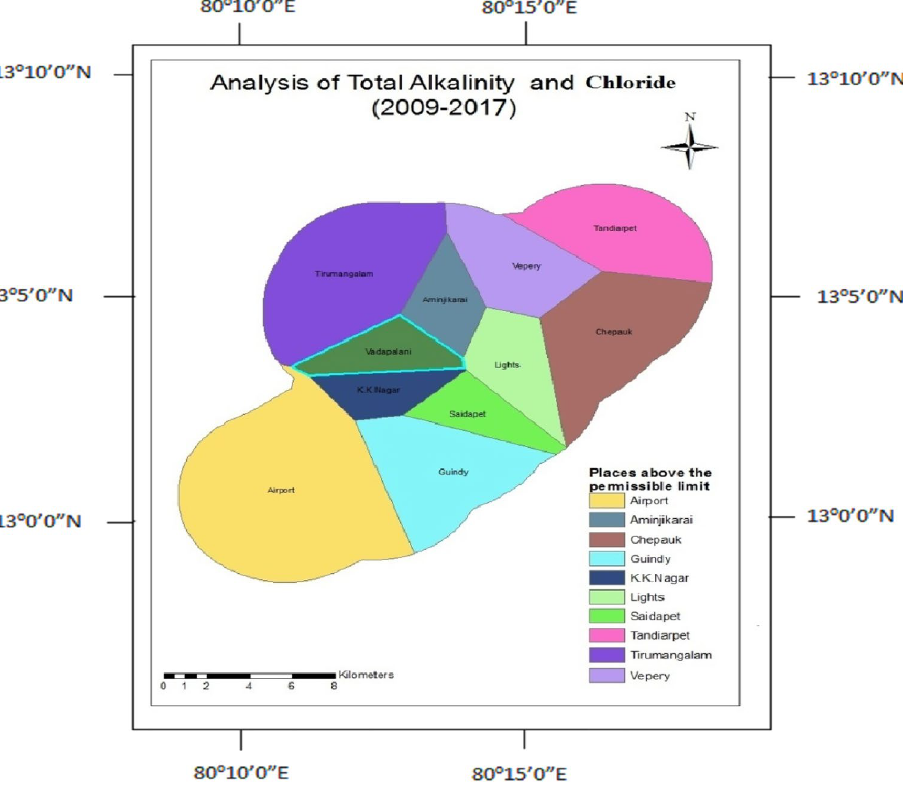
Figure 16. Analysis of total alkalinity and chloride for